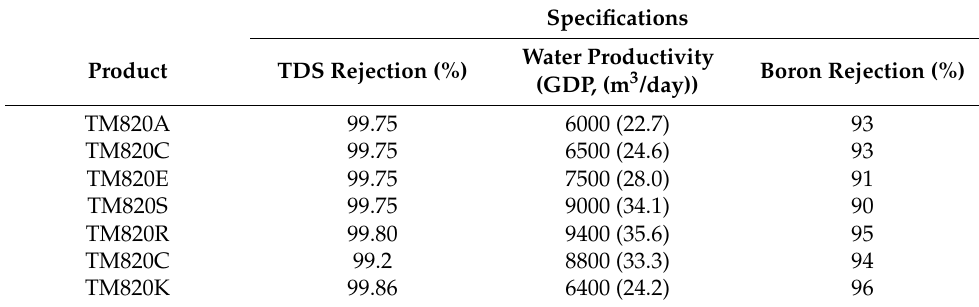
Table 2. Products lineup for Toray’s SWRO [20].